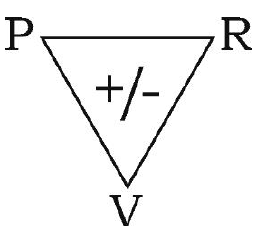
Figure 3: The Positive OK Triangle e) Add the escapes